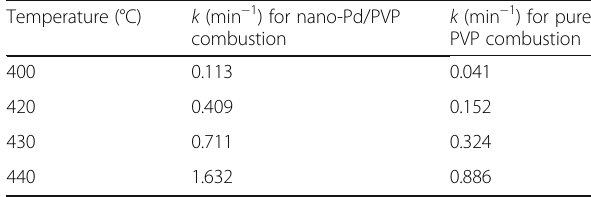
Table 1 Kinetic constants of pure PVP and nano-Pd/PVP com- bustion at different temperatures Temperature